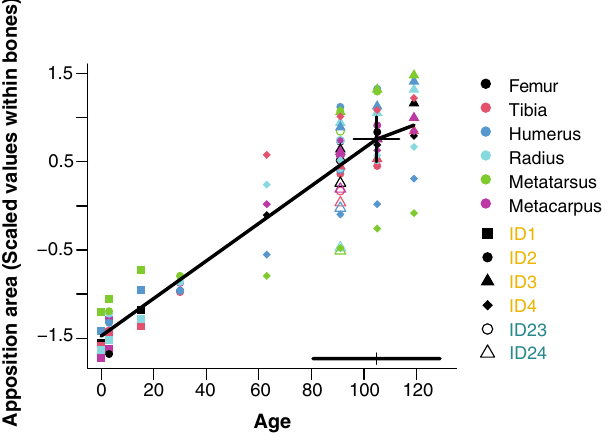
Figure 3. Cumulative apposition areas of bone tissue in six different limb bones during early life (scaled values of bone apposition area in mm 2 , plotted against age in days), of calves nursed by their mothers (C1: ID-23, ID-24), and hand-raised calves (C2: ID-1, ID-2, ID-3, ID-4). The cross indicates a breakpoint estimated by segmented regression, the horizontal bar above the x-axis indicates the 95% confidence interval of breakpoint location in which the weaning event (occurred at the age of 90 days) is included. Slopes of regression below and above the breakpoint differed significantly (F (1,57 ) = 6.25, p = 0.015; linear mixed modelling without a breakpoint yielded a significantly worse fit (model without breakpoints AIC = 32.14; model with breakpoints AIC = 11.22; ∆AICc = 19.92, p < 0.0001).